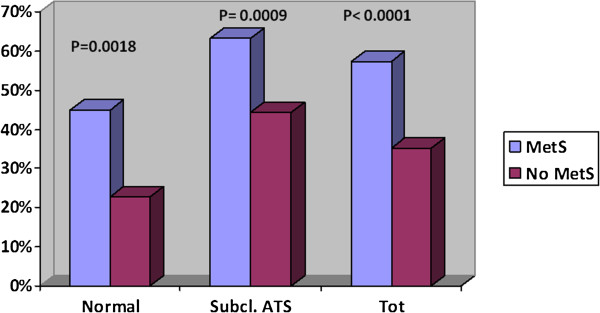
Distribution of cardiovascular events in relation to preclinical atherosclerosis and MetS.